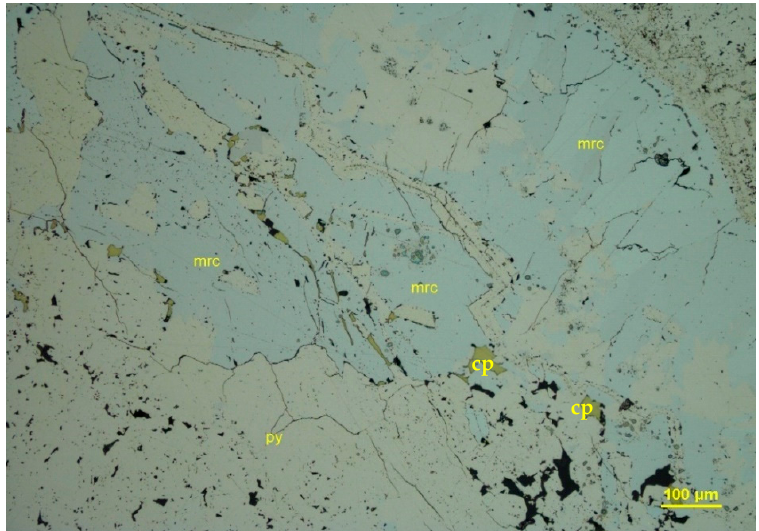
Figure 4. Pyrite (py) hosts medium-grained crystals of marcasite (mrc) and fine-grained crystals of chalcopyrite (cp) from Ore A.